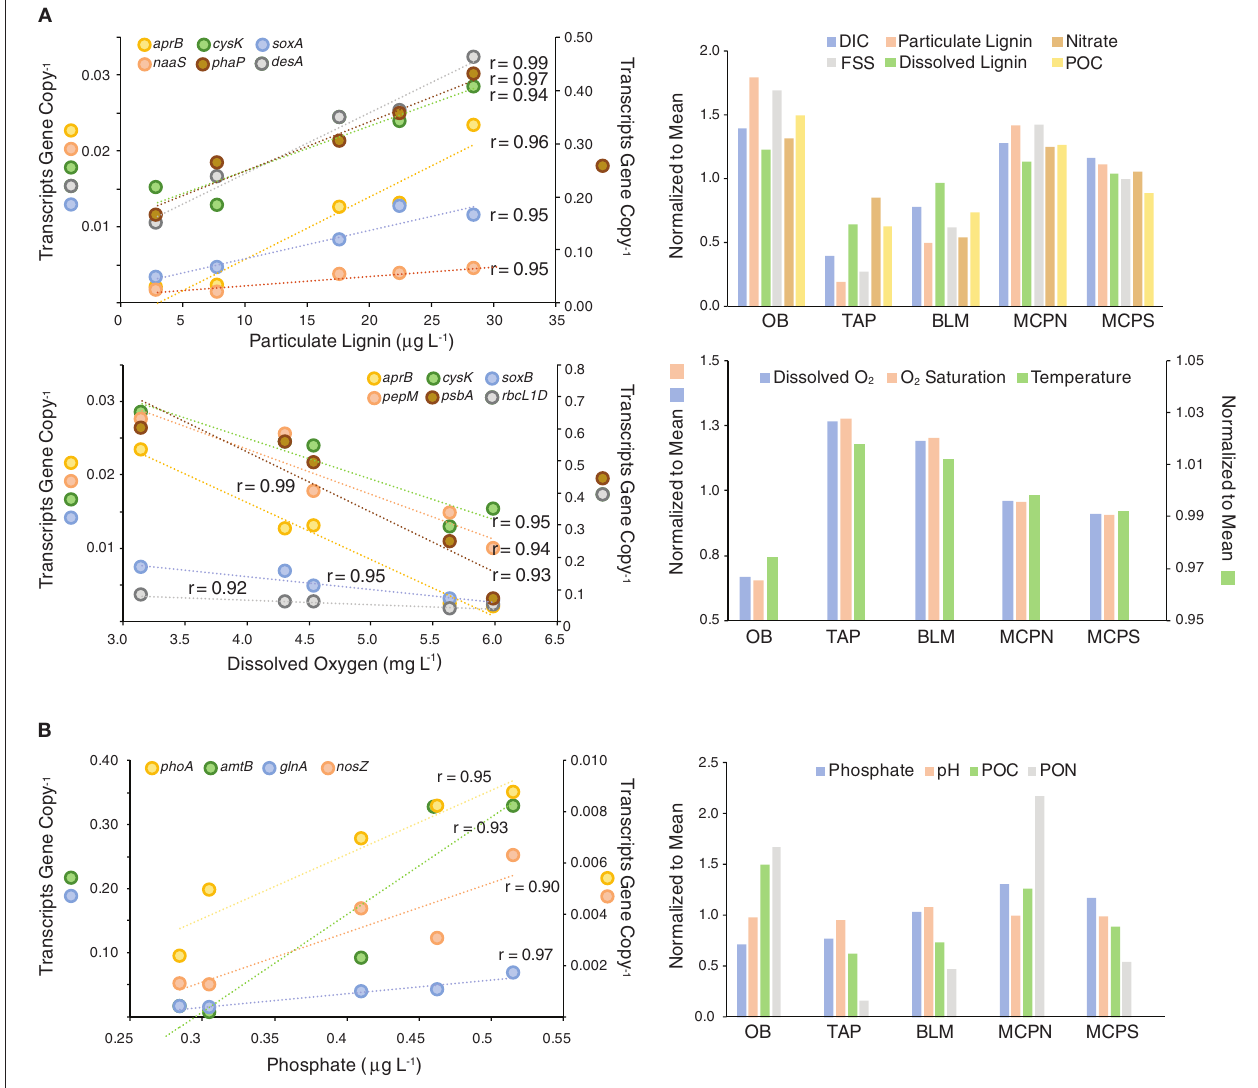
FIGURE 6 | Correlations for high scoring data pairs in a MINE analysis of gene expression ratios and environmental properties for free-living (A) and particle-associated (B) cells. All correlations represent associations with a maximum information coefficient (MIC) > 0.90 and a Pearson’s correlation coefficient > 0.90. Symbols on the Y axis titles show which genes are plotted on each